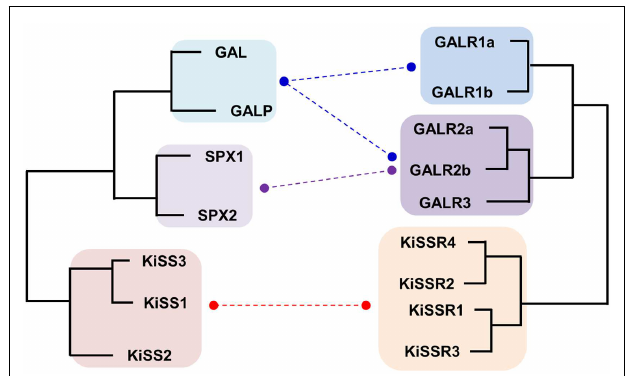
FIGURE 2 | Schematic diagram for the evolutionary relationship between KISS/GAL/SPX family peptides and their corresponding receptors in vertebrates . Paralogs for each peptide and receptor found in vertebrates are included. Functional interaction between the ligands and receptors are indicated by dashed lines.The KISS peptides are able to activate all types of KISSRs with some differences in their ligand potencies but they do not activate any type of GALRs. GALs exhibit high potencies toward GALR1 and GALR2 family receptors but low potencies toward GALR3. SPXs activate GALR2 and GALR3 with high affinities but do not activate GALR1.